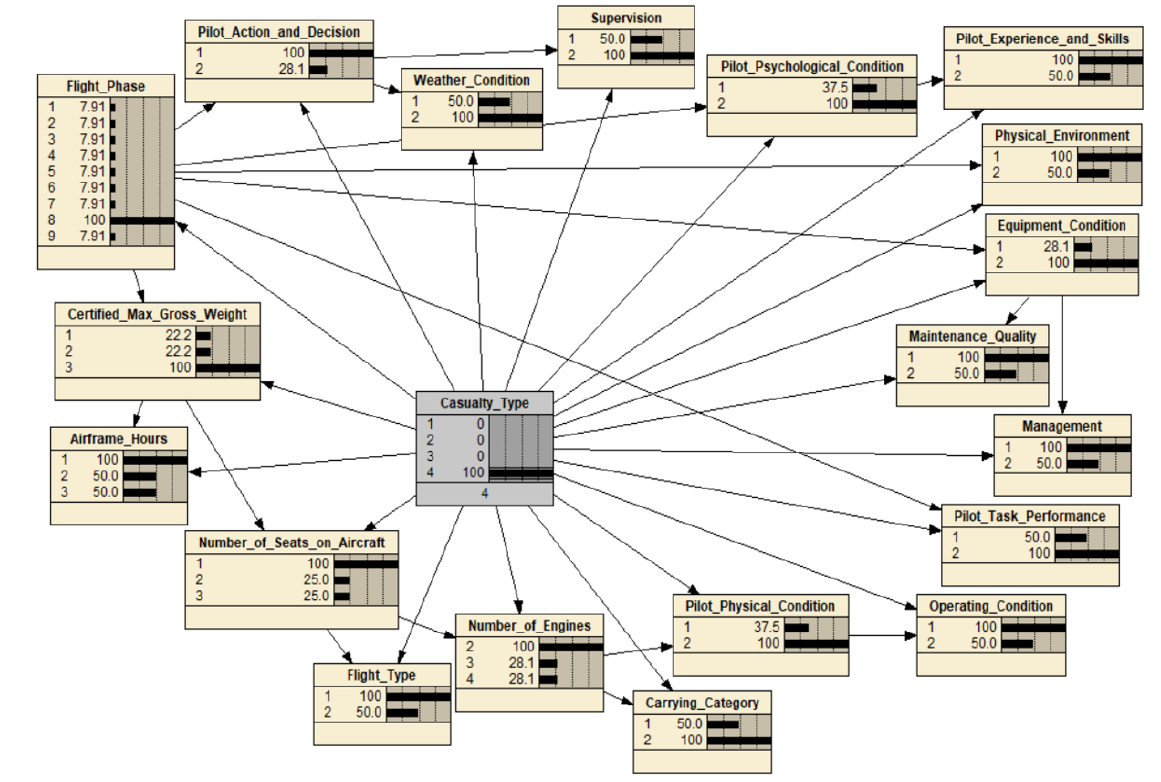
Figure 3. Most Probable Explanation fo r “FATL”. Table 9. Most Probable Explanation for all casualty types.